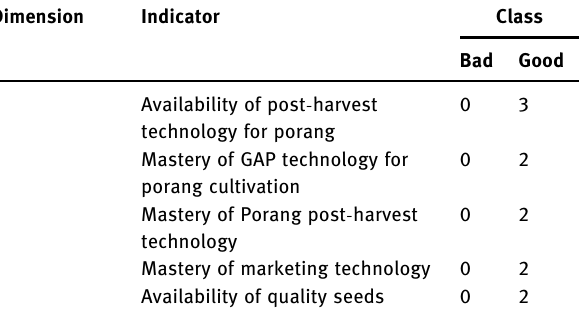
Table 1: Dimensions and indicators for measuring